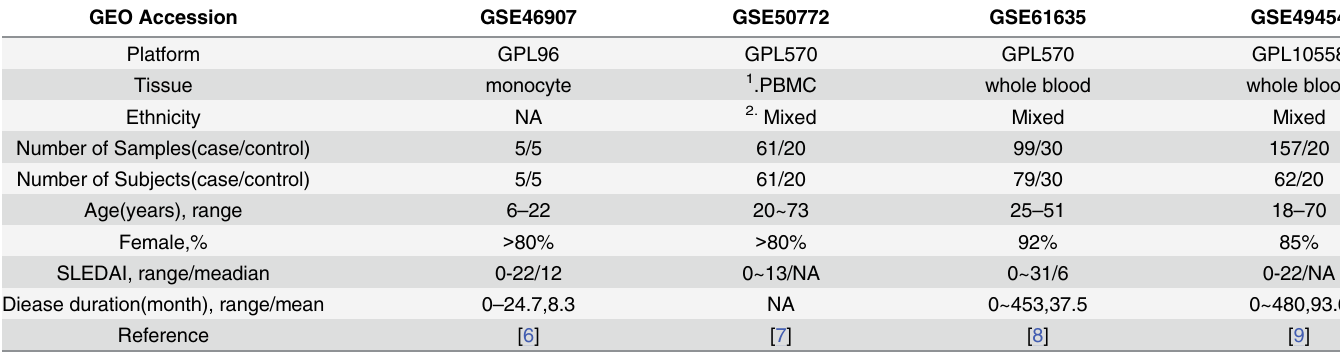
Table 1. Information of the Eligible Microarray Gene Expression